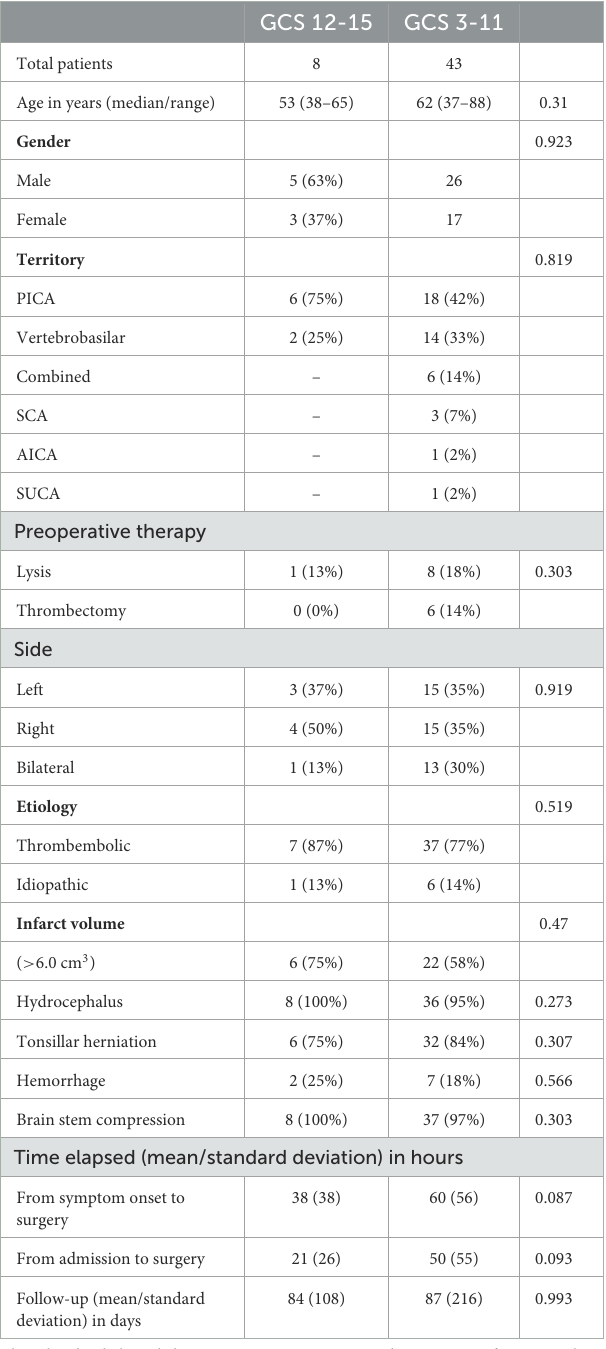
TABLE 5 Characteristics of patients with GCS scores of 12–15 vs. GCS scores of 3–11 at the